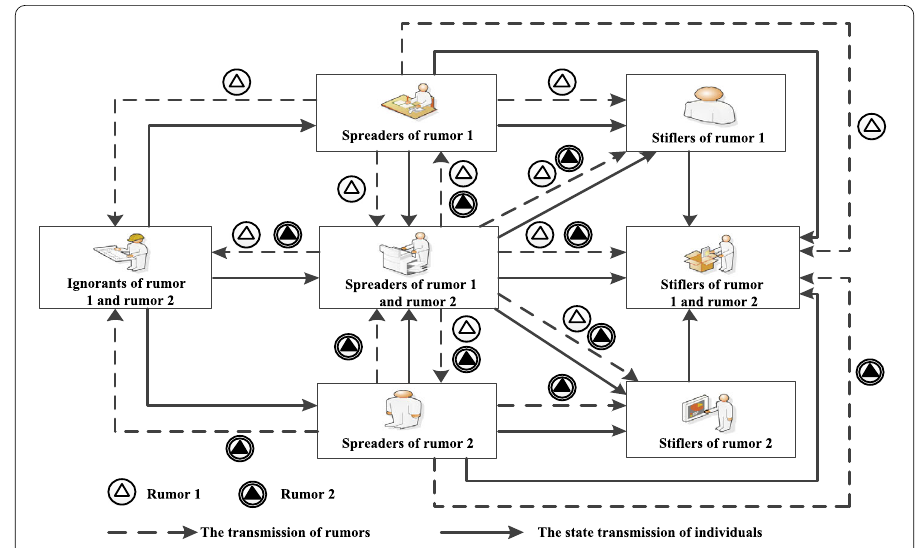
Figure 4 The state transmission of different individuals due to